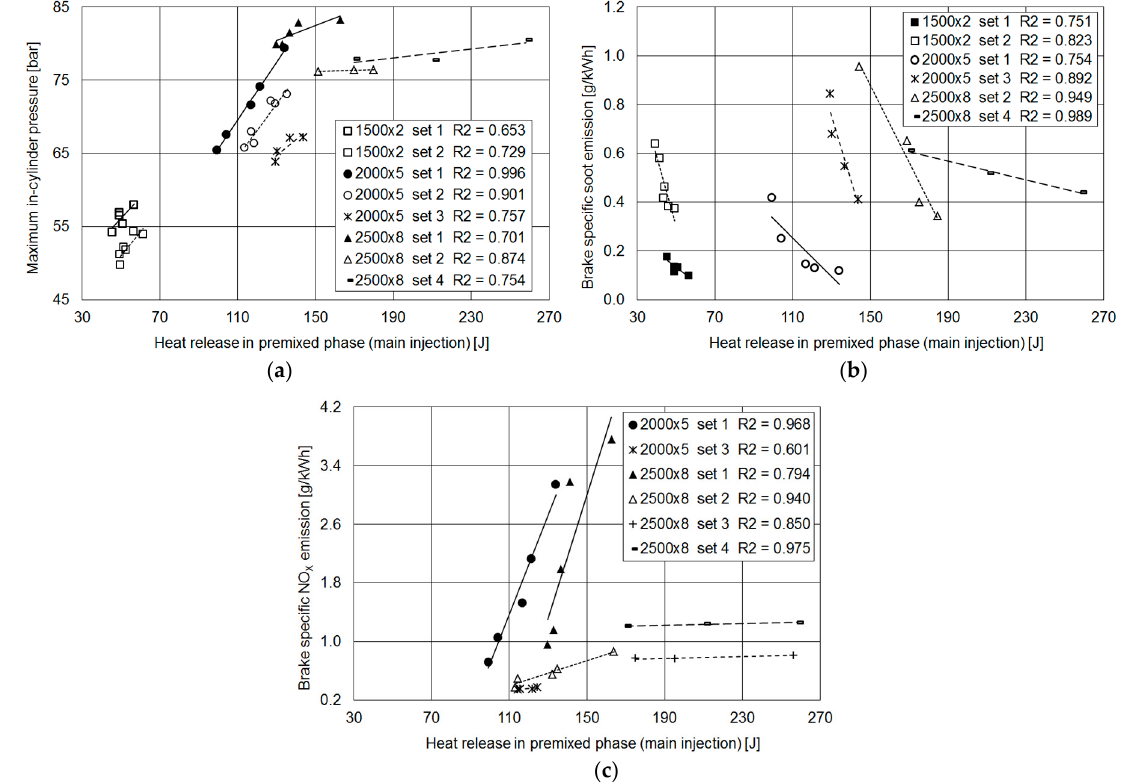
Figure 7. Relationship between HR premix and p MAX ( a ), bsS ( b ), bsNO X ( c ) in different test sets.